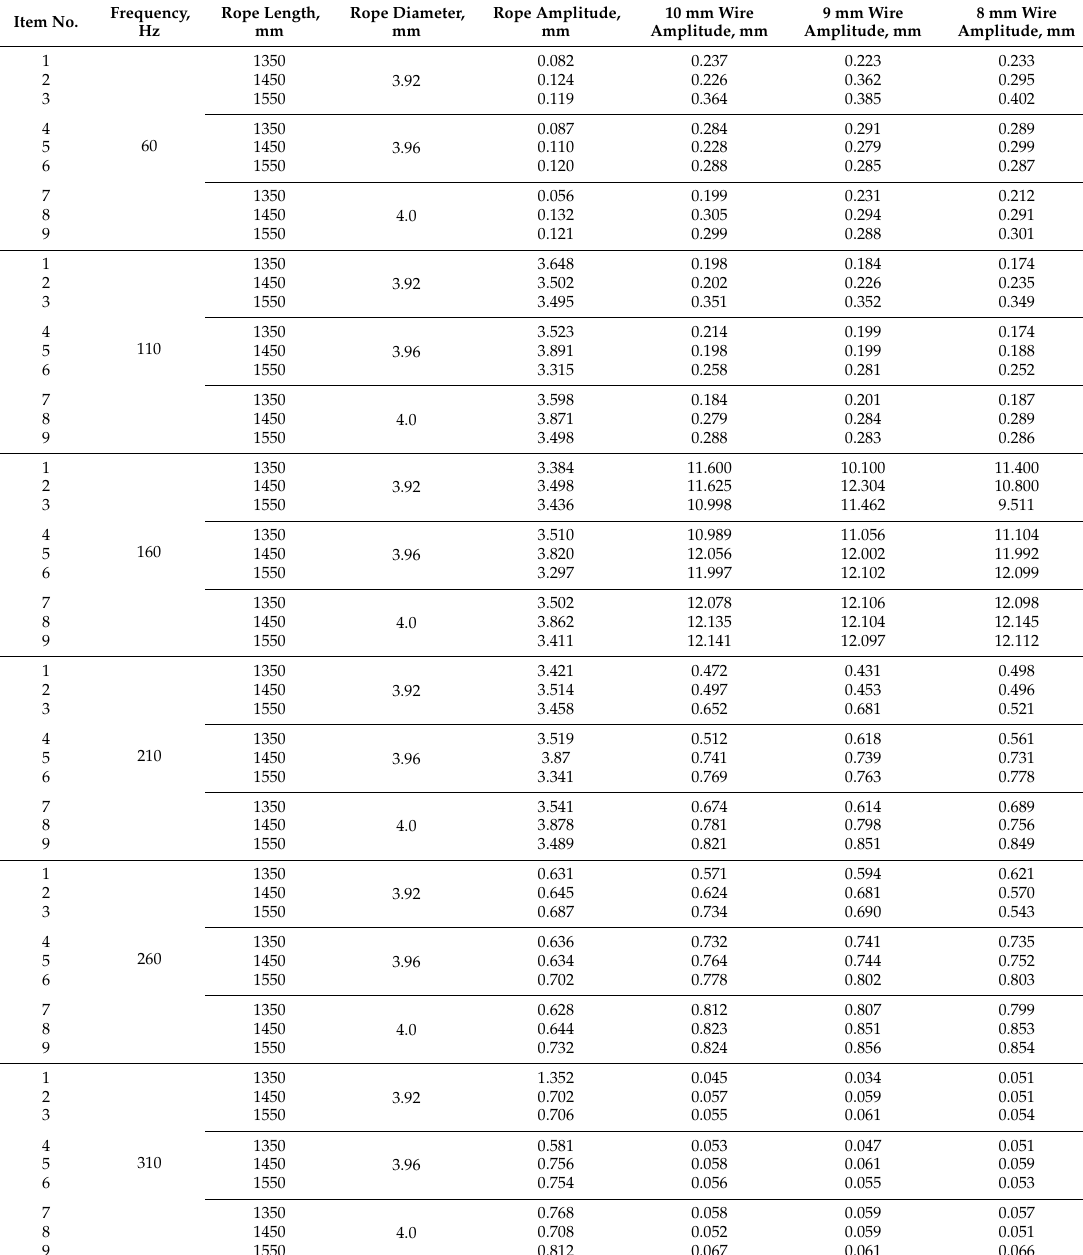
Table A1. Rope vibration experimental